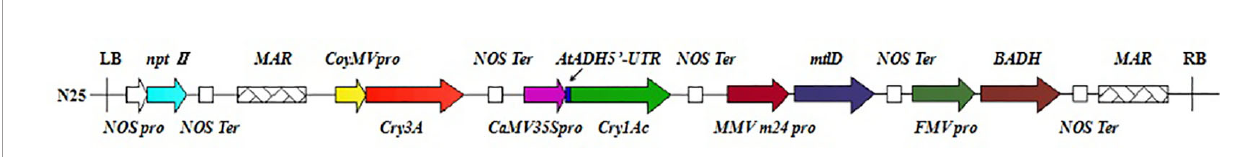
FIGURE 1 | Construction of plant transformation vector with multiple insect-resistant and salt-tolerant genes. N25, the code name of the process bacterium formed after vector transfer to agrobacterium; LB, vector left boundary; NOS pro, promoter of neomycin phosphotransferase gene; nptII , neomycin phosphotransferase gene; NOS Ter, terminator of neomycin phosphotransferase gene; MAR, the molecular structure of the matrix attachment region of tobacco; CoyMV pro, commelina yellow mottle virus promoter; Cry3A , bacillus thuringiensis insecticidal crystal protein gene; CaMV35S, cauli fl ower mosaic virus CaMV35S promoter; AtADH5 ’ -UTR,